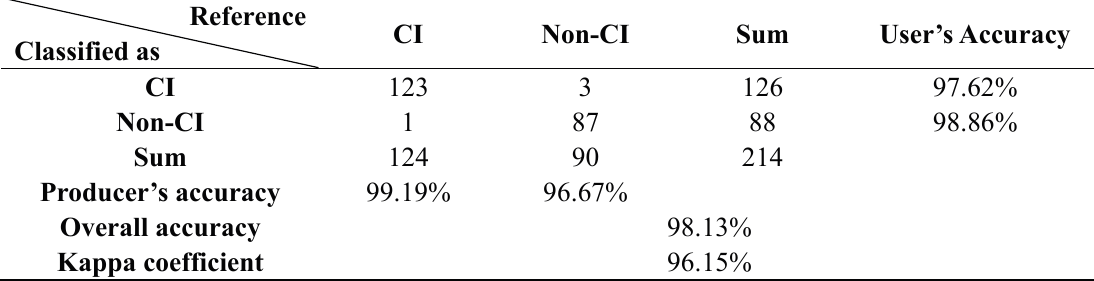
Table 4. Accuracy assessment results for the DT model using the test dataset.